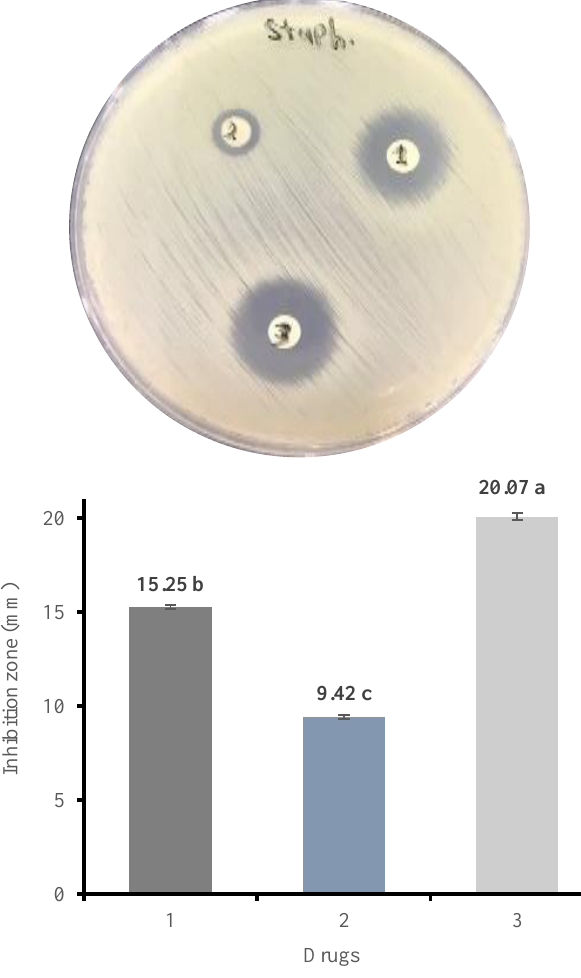
Figure 1 . The discs' growth inhibition zone (mm). 1=gentamicin 10 μg ; 2=silver nanoparticles (AgNPs) 10 μg/m L, 3=gentamicin+AgNPs